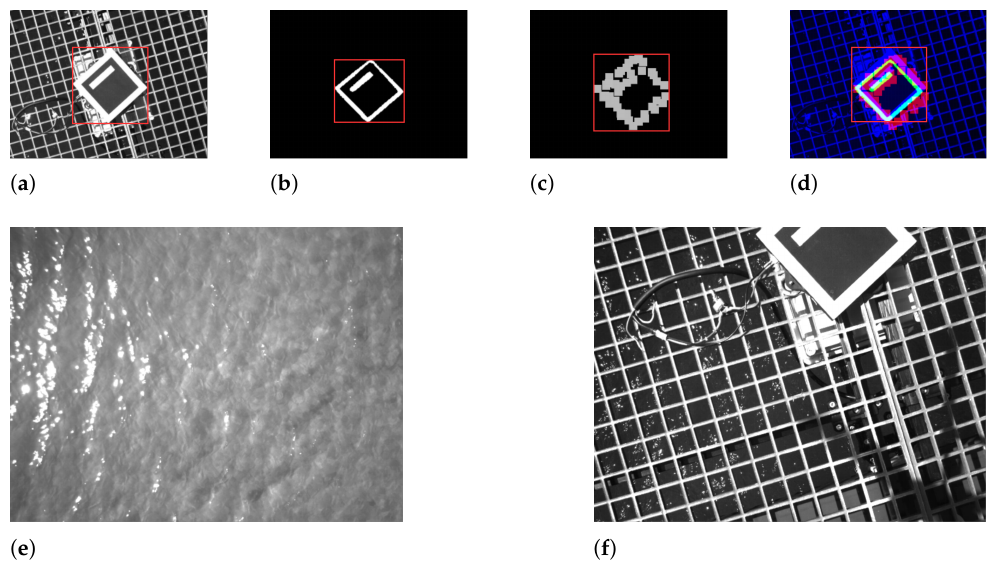
Figure 11. Non-null annotations on the top and null annotations on the bottom. ( a ) A visual sample annotation. ( b ) A thermal sample annotation. ( c ) A LiDAR sample annotation. ( d ) A fused sample annotation. ( e ) A null example (no object present). ( f ) A null example (partially present